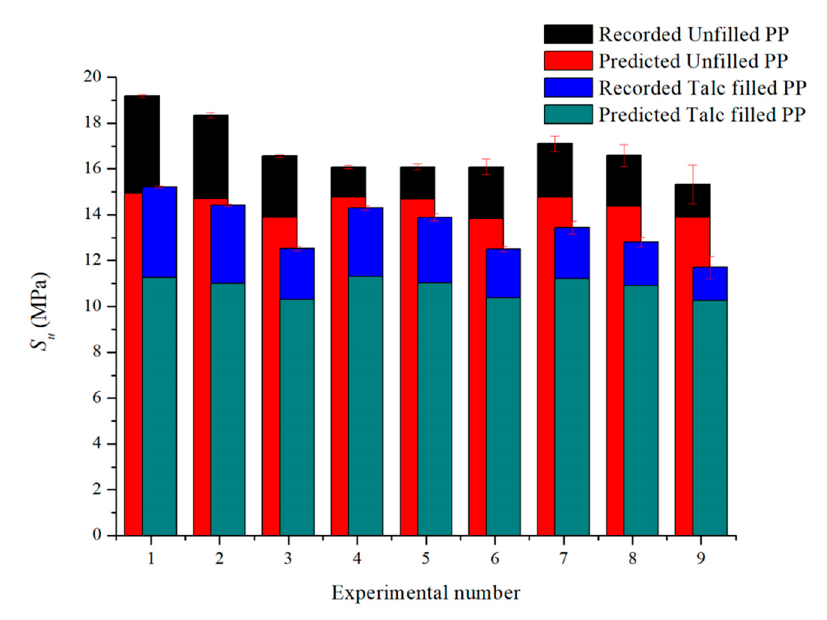
Figure 3. Recorded and predicted Ultimate Tensile Strengths for both polymers.